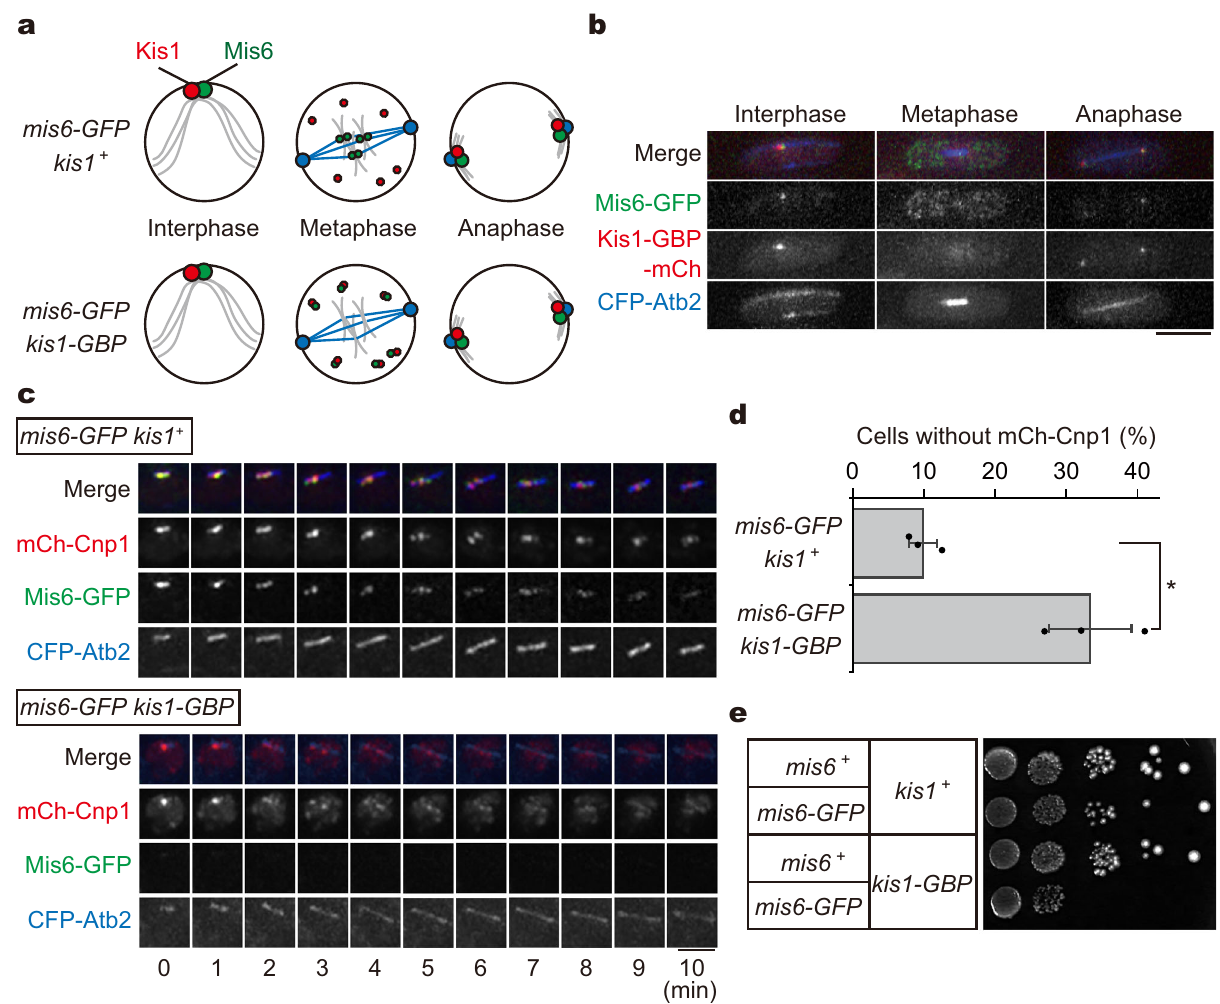
Fig. 3 Metaphase-speci fi c removal of Mis6 causes a decrease of Cnp1. a Schematics illustrating the outline of knocksideways to remove Mis6 from centromeres only during metaphase using Kis1. Kis1 (red) and Mis6 (green) co-localise to centromeres during interphase, but Kis1 disperses at mitosis onset ( mis6-GFP kis1 + ). In cells co-expressing Kis1-GBP and Mis6-GFP, Kis1-GBP brings Mis6-GFP out of centromeres only during metaphase ( mis6-GFP kis1-GBP ). b Cells expressing Mis6-GFP (green), Kis1-GBP-mCherry (red) and CFP-Atb2 (cyan fl uorescent protein fused with α 2-tubulin, blue) at each cell cycle stage. Scale bar = 5 µ m. c Prometaphase cells expressing Mis6-GFP (green), mCh-Cnp1 (red) and CFP-Atb2 (microtubules; cyan) together with untagged Kis1 ( mis6-GFP kis1 + ) or Kis1-GBP ( mis6-GFP kis1-GBP ) were imaged. Scale bar = 2 µ m. d Population of metaphase cells without mCherry-Cnp1 at centromeres ( N = 3 experiments). Error bars = ±s. d. * p < 0.05 (Welch ’ s t -test). e Growth assays for indicated strains. Cells at ten-fold serial dilutions were grown in EMM at 36